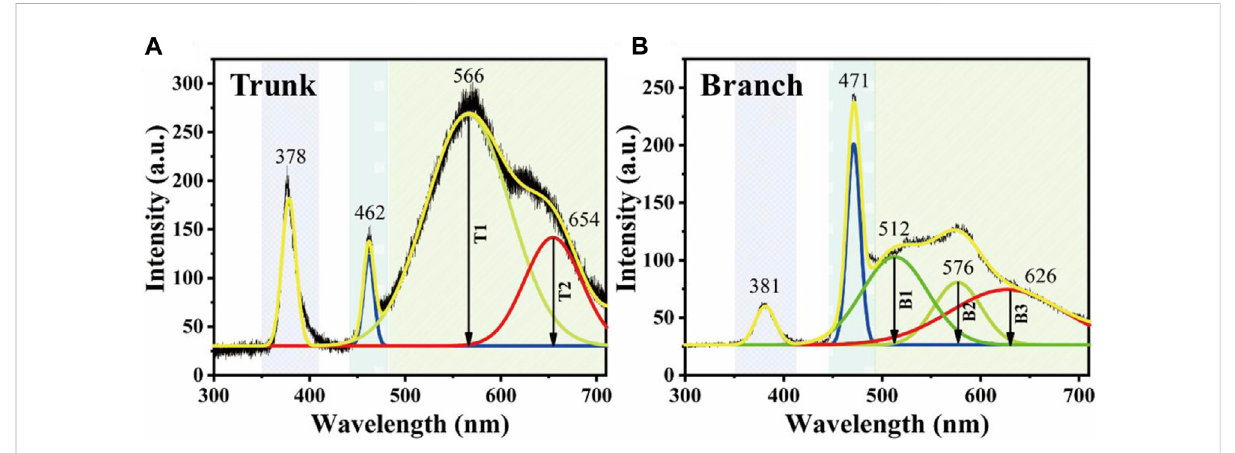
FIGURE 5 PL spectrum of ZnSe nanowires with the (A) trunk and (B) the topological